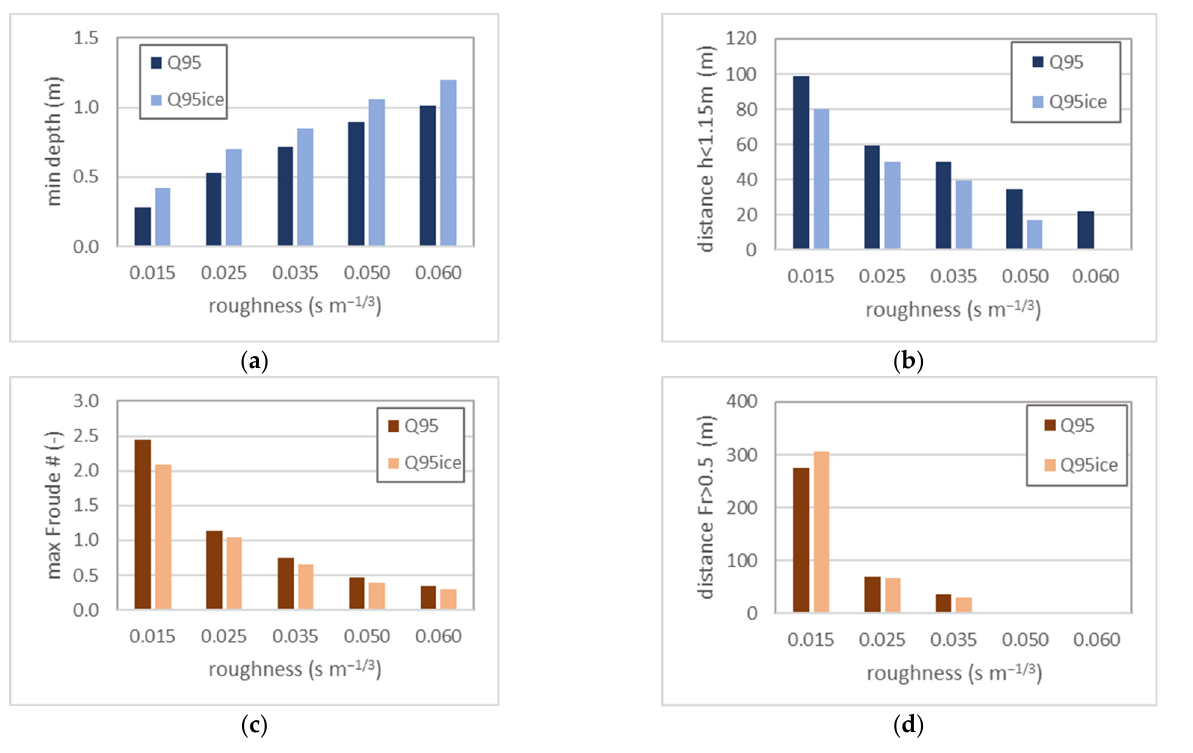
Figure 13. Summary of results for Q 95% and Q 95%,ice : ( a ) minimum depth, ( b ) the distance with the depth below 1.15 m, ( c ) maximum Froude #, ( d ) the distance with Froude # above 0.5.